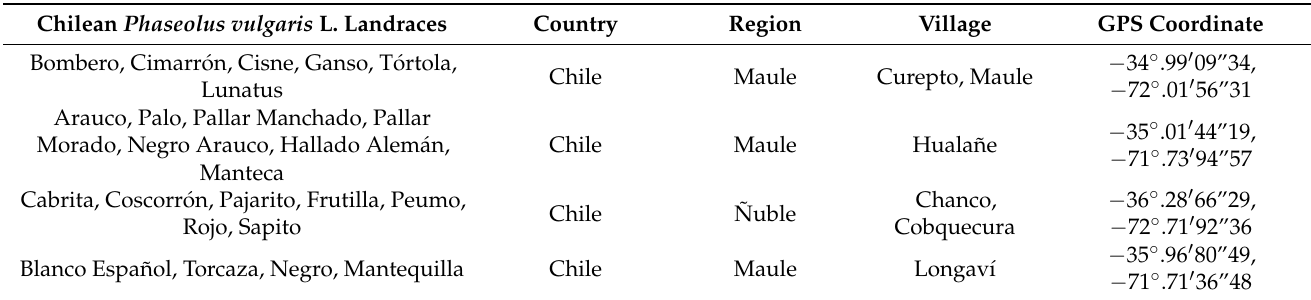
Table 4. Description of the landraces of P. vulgaris